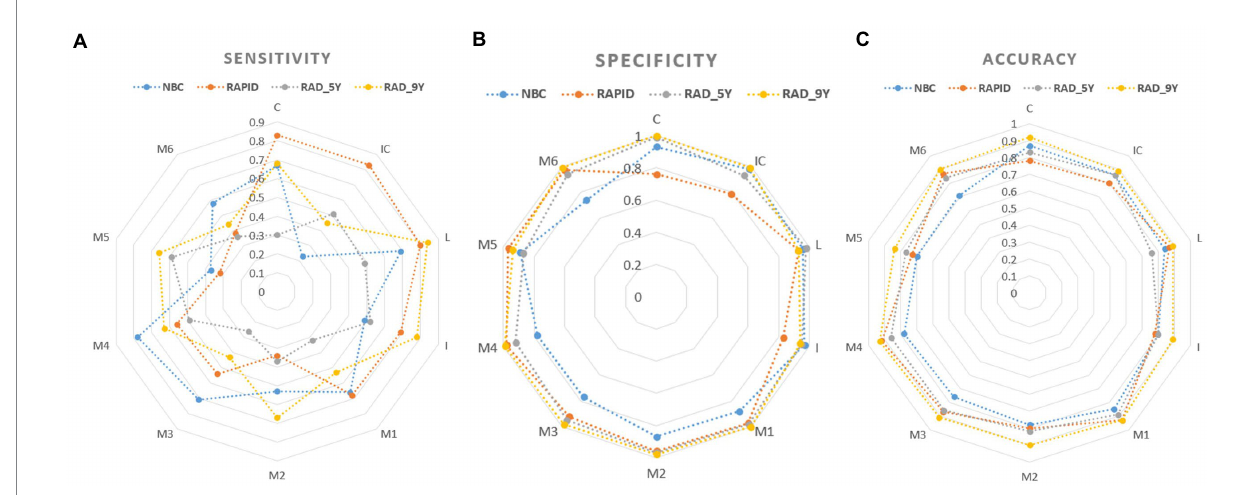
FIGURE 5 Visualization of the sensitivity (A) , specificity (B) and accuracy (C) for baseline ASPECTS.